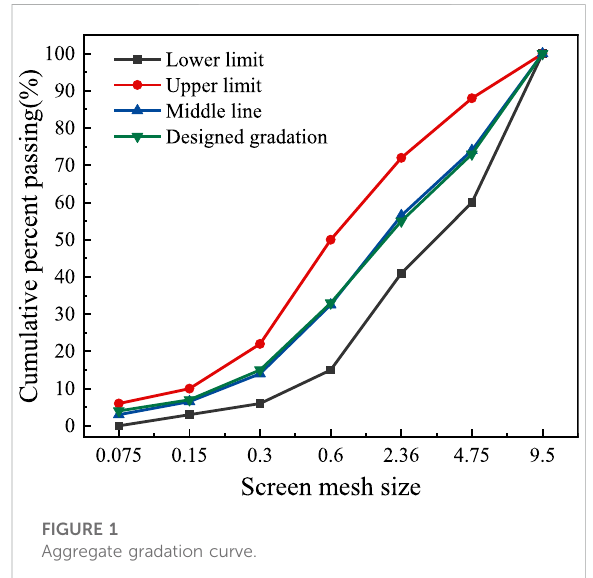
FIGURE 1 Aggregate gradation